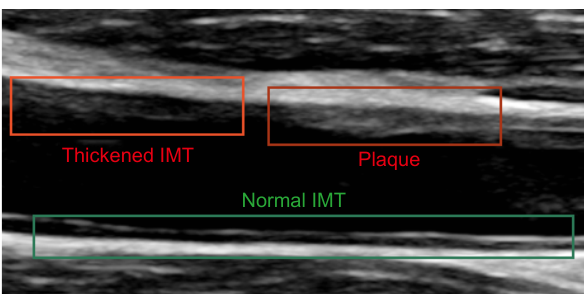
Figure 1 Normal, thickened, and plaque in longitudinal carotid